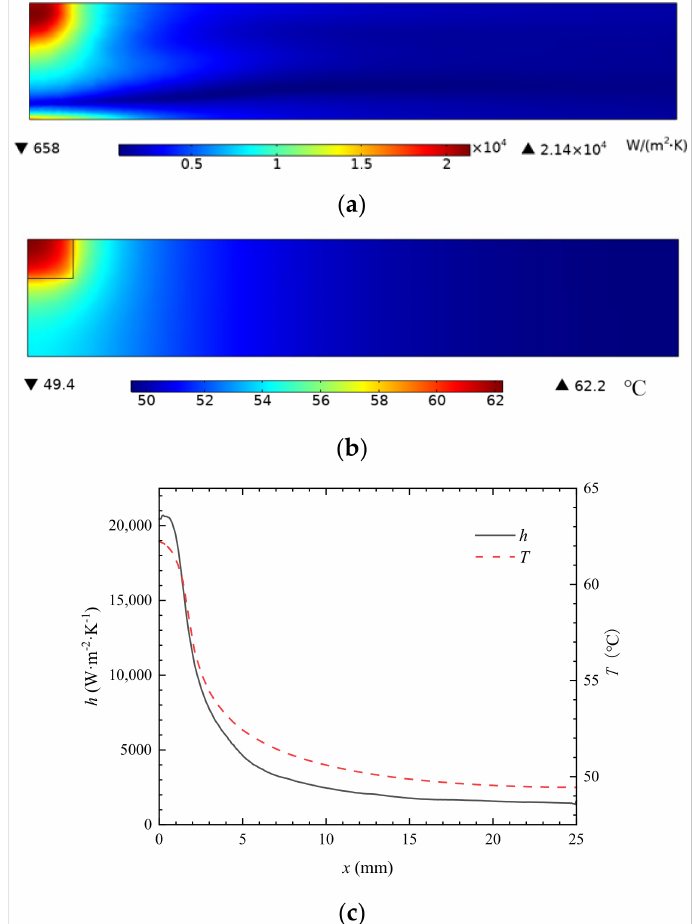
Figure 4. The distribution of heat transfer coefficient and temperature: ( a ) the heat transfer coefficient distribution of the jet impingement surface; ( b ) the temperature distribution of the heat sink bottom; ( c ) the heat transfer coefficient and temperature distribution of the symmetric line.